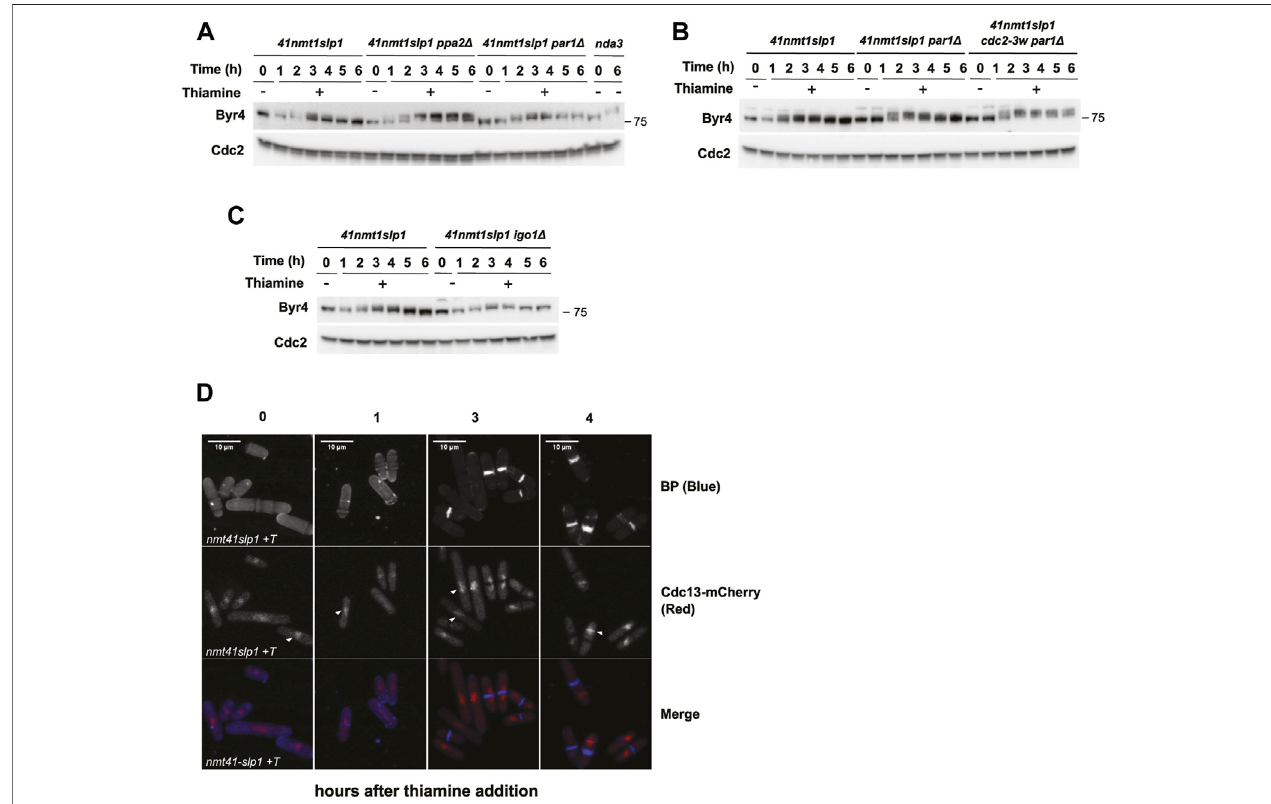
FIGURE5| Dynamic Byr4phosphorylationand Cdc13localisation duringasustainedmetaphasearrest. (A – D) Cells weregrownexponentiallyinEMM( p41-nmt1 promoterinduced)andshiftedtoEMM+T( p41-nmt1 promoterrepressed)at30 ° C.Sampleswerecollectedattheindicatedtimepointsformicroscopyandwesternblot. For the nda3-3KM311 mutant, cells weregrown at 30and then shifted to18 ° Cfor 6 h. (A,C) Byr4levels and phosphorylation(band shift)were detected bywestern blot in p41-nmt1:slp1 , p41-nmt1:slp1 ppa2 Δ , p41-nmt1:slp1 par1 Δ and nda3-3KM311 mutant (A) ; p41-nmt1:slp1 , p41-nmt1:slp1 par1 Δ and p41-nmt1:slp1 cdc2- 3w par1 Δ (B) and p41-nmt1:slp1 and p41-nmt1:slp1 igo1 Δ (B) or p41-nmt1:slp1 and p41-nmt1:slp1 igo1 Δ strains (C) in EMM -T and EMM +T at the indicated time points. Cdc2 (PSTAIR) wasused asaproteinloadingcontrol. (D) Representativeimages of cdc13mCherry localizationandBlankophor-stainedethanol- fi xedcells upon slp1 repression by thiamine. Scale bar 5